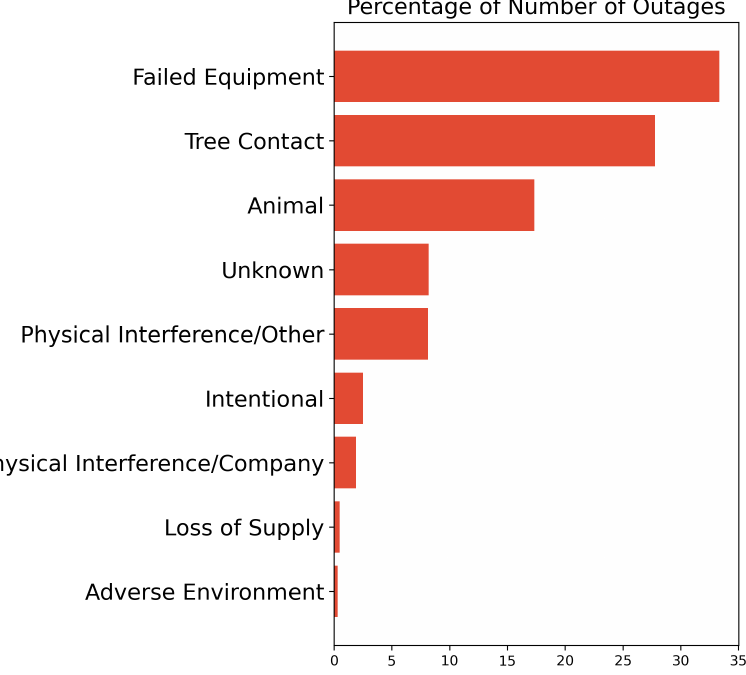
Figure 10. Bar chart showing the causes of NWO in MA based on outage data from 2013–2018